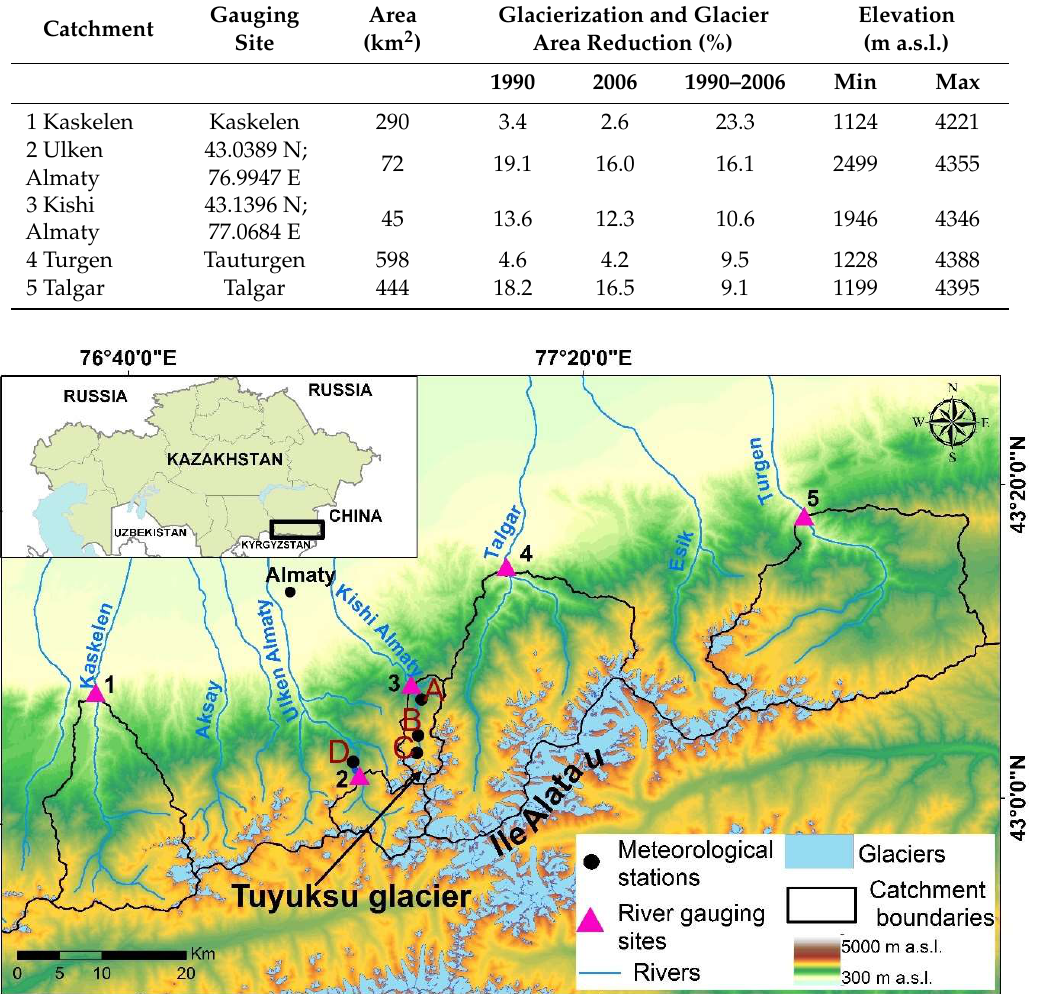
Table 1. Characteristics of the study catchments. Minimum elevation corresponds to the elevation of the flow gauge which provided data used in this study.